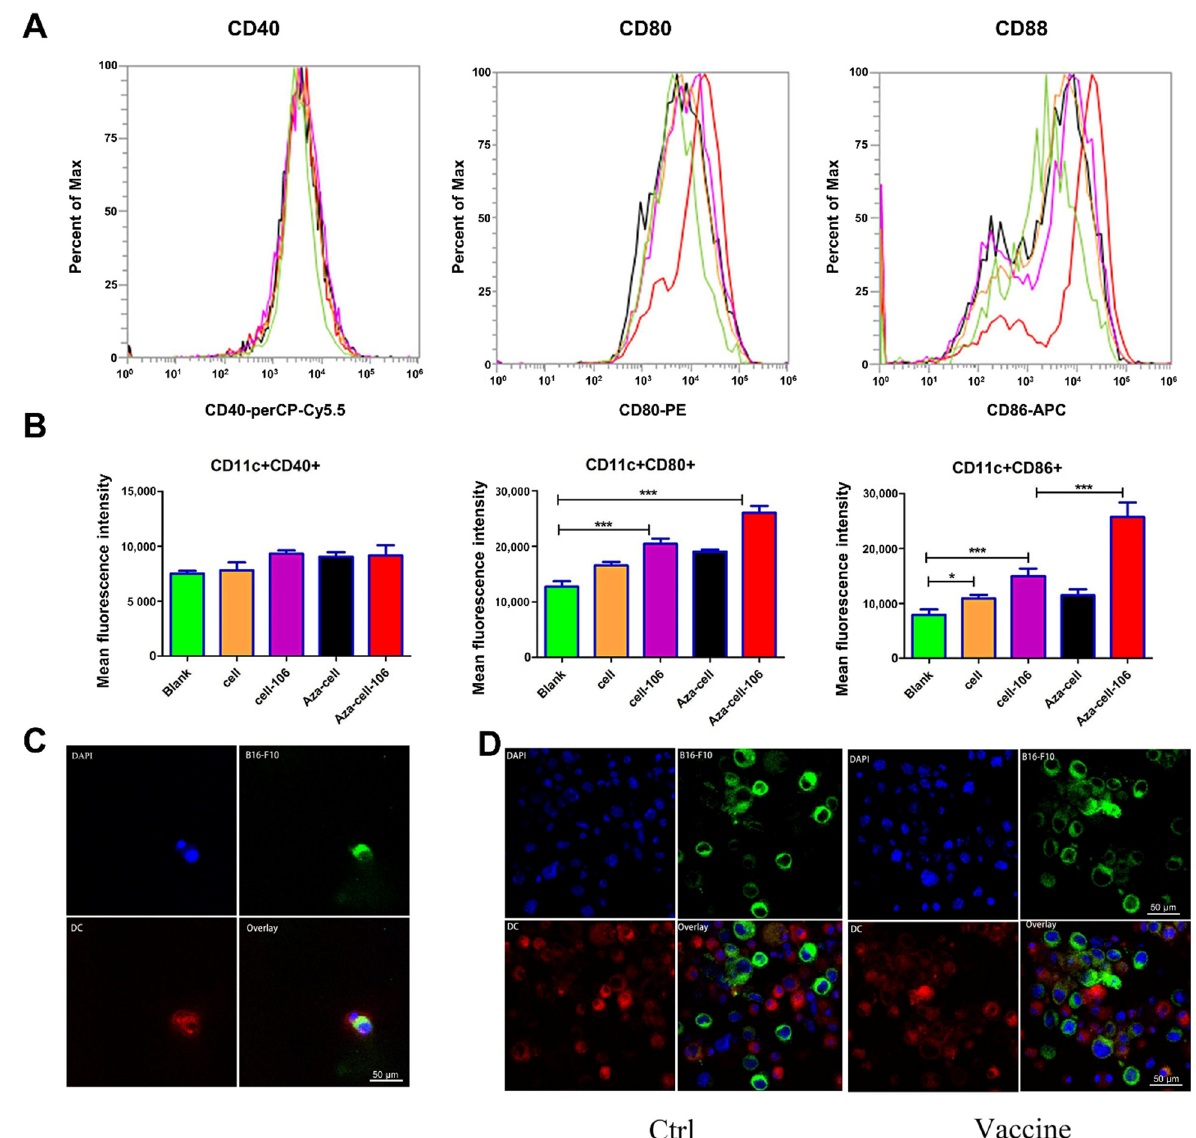
Figure 4. Aza-BFcell-106 promoted the maturation of BMDCs without affecting BMDC phagocytosis. ( A ). The peak map shows that the peak for Aza-cell-106 is shifted to the right of the peak for the blank group. ( B ). Average fluorescence intensity was analyzed from the corresponding peak map. The colors representing the different groups were kept consistent between the peak map in ( A ) and the data in ( B ). The graph shows the mean ± SD value ( n = 3) of one representative experiment. The same results were obtained in three replicate experiments. * p < 0.05; *** p < 0.001. ( C , D ). DCs (red) phagocytosed B16-F10 cells (green) conjugated with SZU-106. ( C ) shows the phagocytic function of a single DC. ( D ) shows the phagocytic function of DCs in the control group and Aza-BFcell-106 group. Blue indicates DAPI staining.